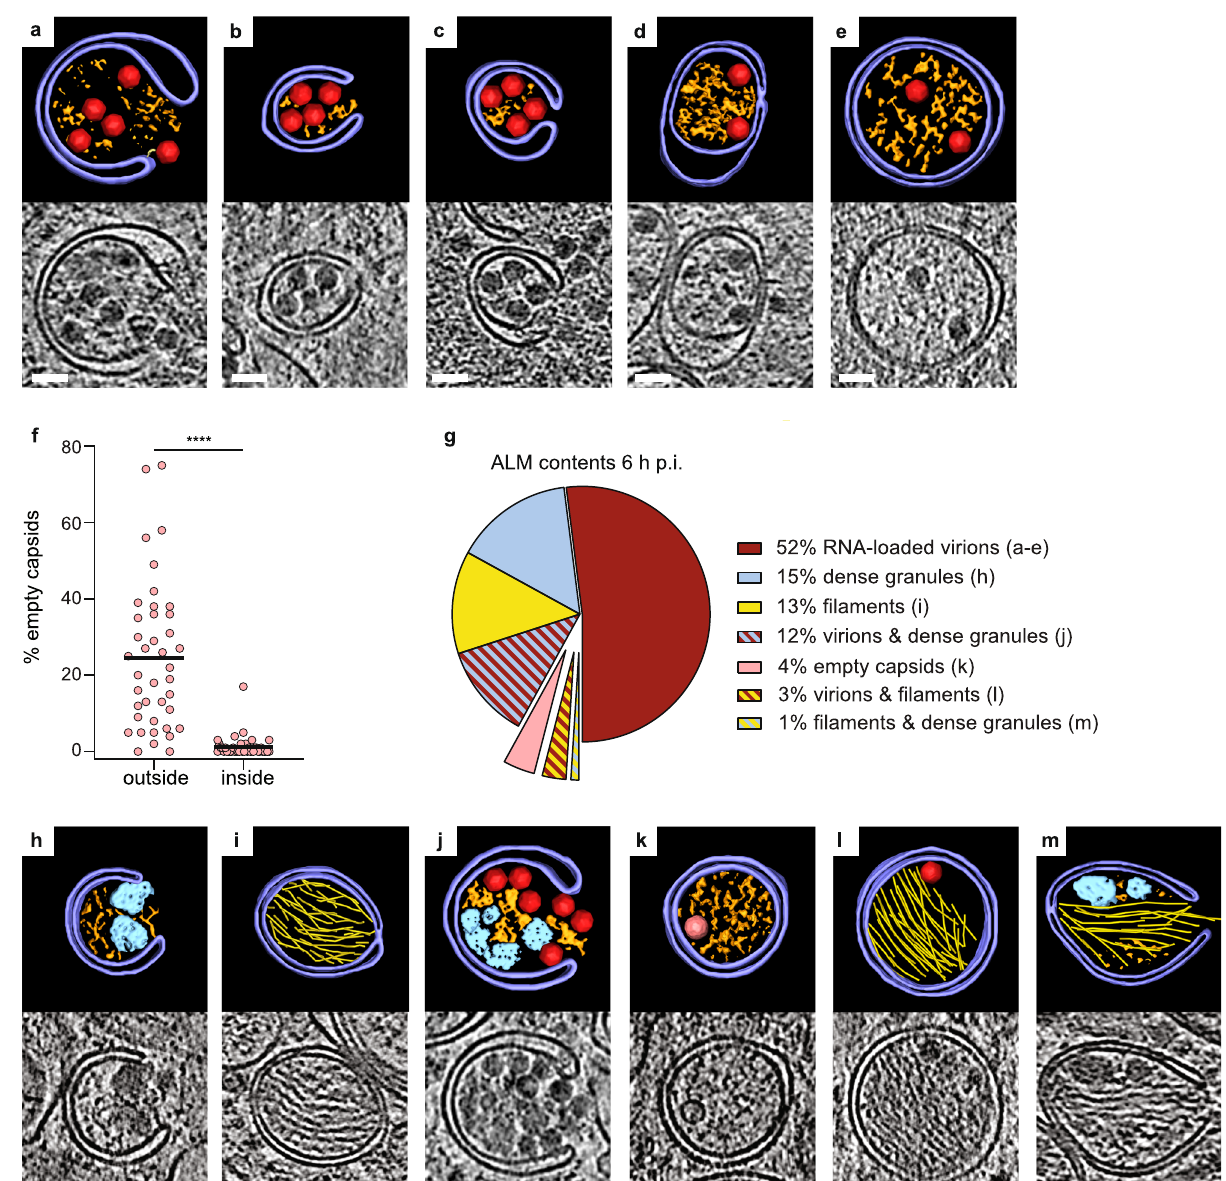
Fig.5|Autophagy-likemembranesselectandsorttheircontentsinPV-infected cells.a – e TomogramsofPV-infectedcellsat6 hp.i.showingdifferentstagesof engulfment of RNA-loaded virions by ALMs, including initial recruitment to phagophores ( a – c ) and enclosure in DMVs ( d , e ). Each panel contains a slice through the tomogram and the corresponding segmentation, colored as in Fig. 1b. f Percentage of empty capsids on the outside and inside of ALMs. Each dot corresponds to one tomogram analyzed ( n = 41); horizontal line is the